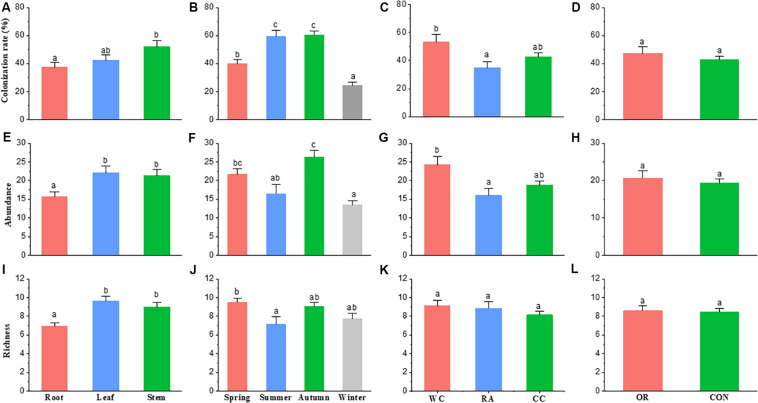
The difference in fungal endophyte colonization rate, abundance and richness within [(A), (E), and (I) respectively] host plant parts, [(B), (F), and (J) respectively] seasons, [(C), (G), and (K) respectively] host plant species and [(D), (H), and (L) respectively] farming practice. The bar shows the mean + standard error; same letters on the bars are not significantly different at level of P < 0.05. CC, Chinese cabbage; WC, white cabbage; RA, radish; OR, organic; CON, conventional farm.